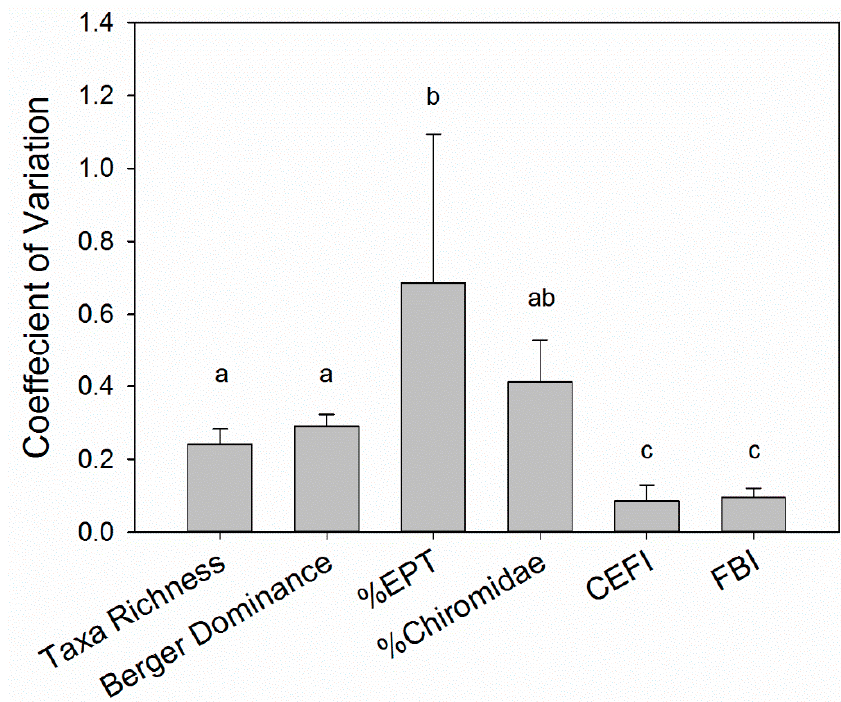
Figure 4. Comparison of mean coefficients of variation (bars) for bioassessment metrics calculated for eight streams sampled at least 14 years. Error bars indicate one standard deviation. Letters indicate pairwise differences ( p < 0.05) among metrics in terms of the amount of interannual variation as indicated by the coefficients of variation such that metrics with the same letters did not differ.